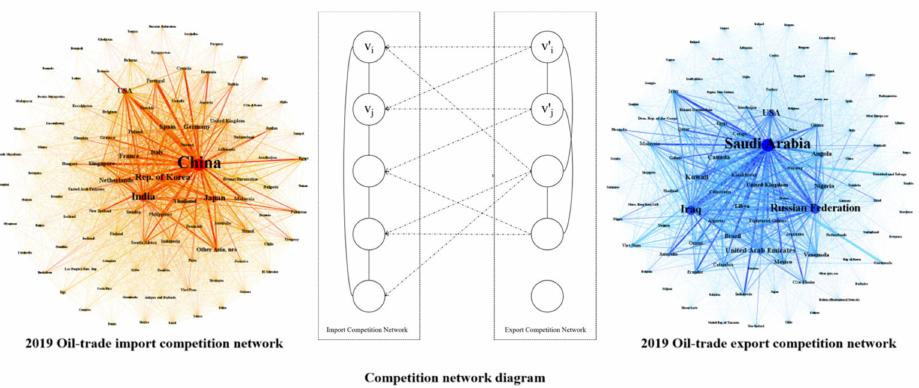
Figure 1. Competition network